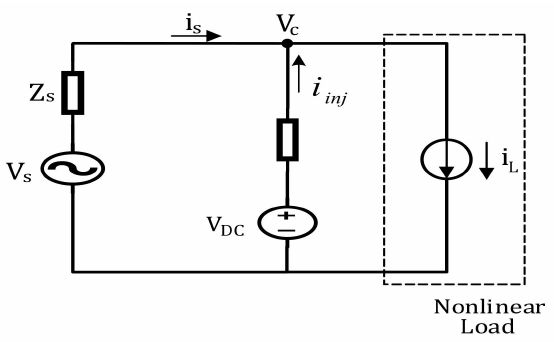
Figure 2. The equivalent electrical circuit of a single-phase active power